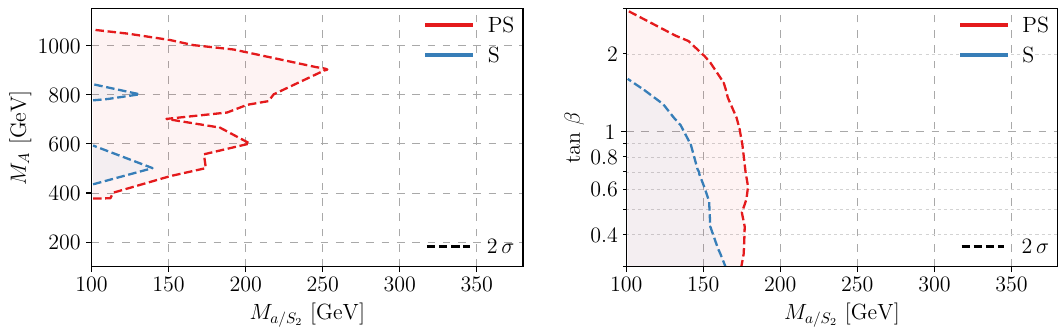
Figure 11 . 2 (cid:27) exclusion limits from mono- h searches in M plane (right) for the 2HDM+S (blue) and PS (red). In both plots we use the parameters as given in eq. (4.4) with tan (cid:12) = 1 for the left one and M A = 500 GeV for the right one.